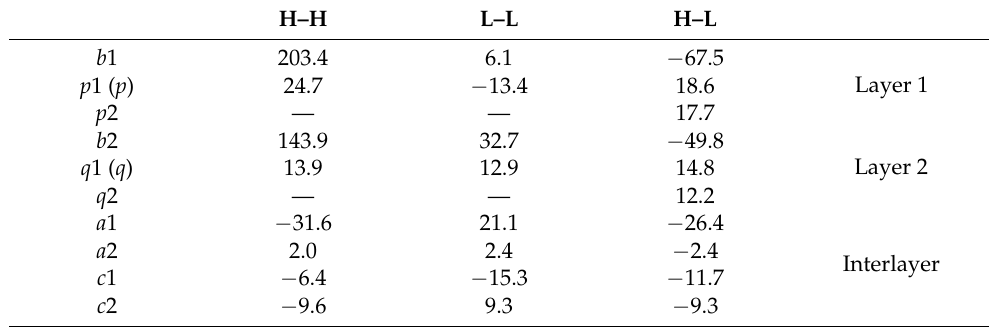
Table 5. HOMO–HOMO (H–H), LUMO–LUMO (L–L), and HOMO–LUMO (H–L) transfer integrals (meV) at 10.6 GPa (Structure